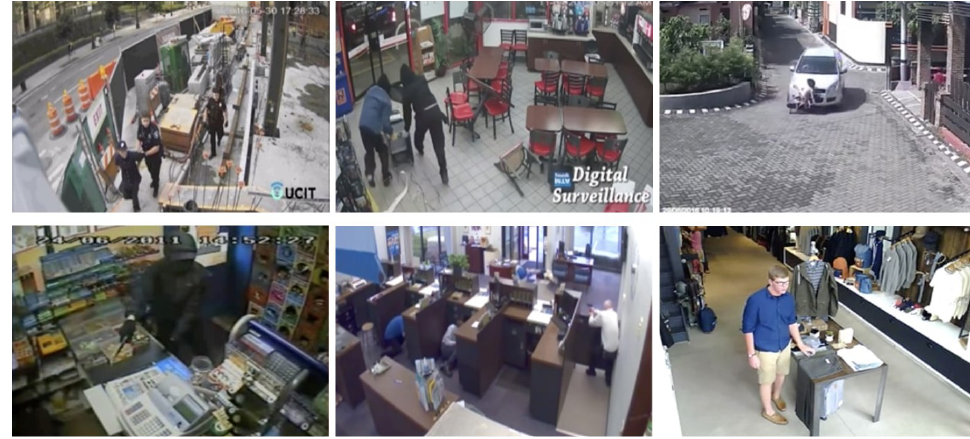
Figure 7. Examples of abnormal frames from the HR-Crime dataset are presented.